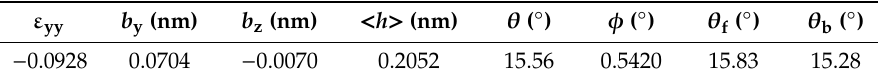
Table 1. The numerical solutions of orientation relationship (OR) and interface orientation (IO) determined by the topological